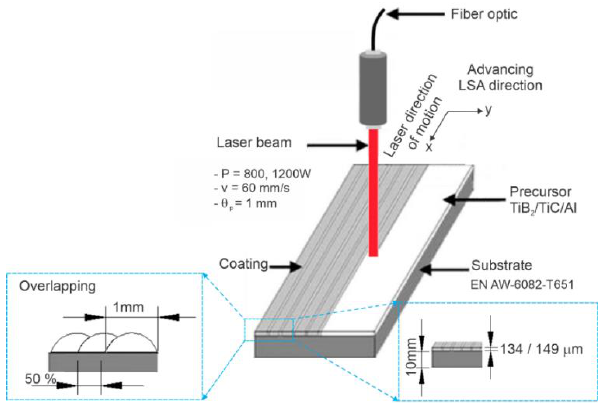
Figure 1. Schematic presentation of laser surface alloying (LSA) experimental procedure.